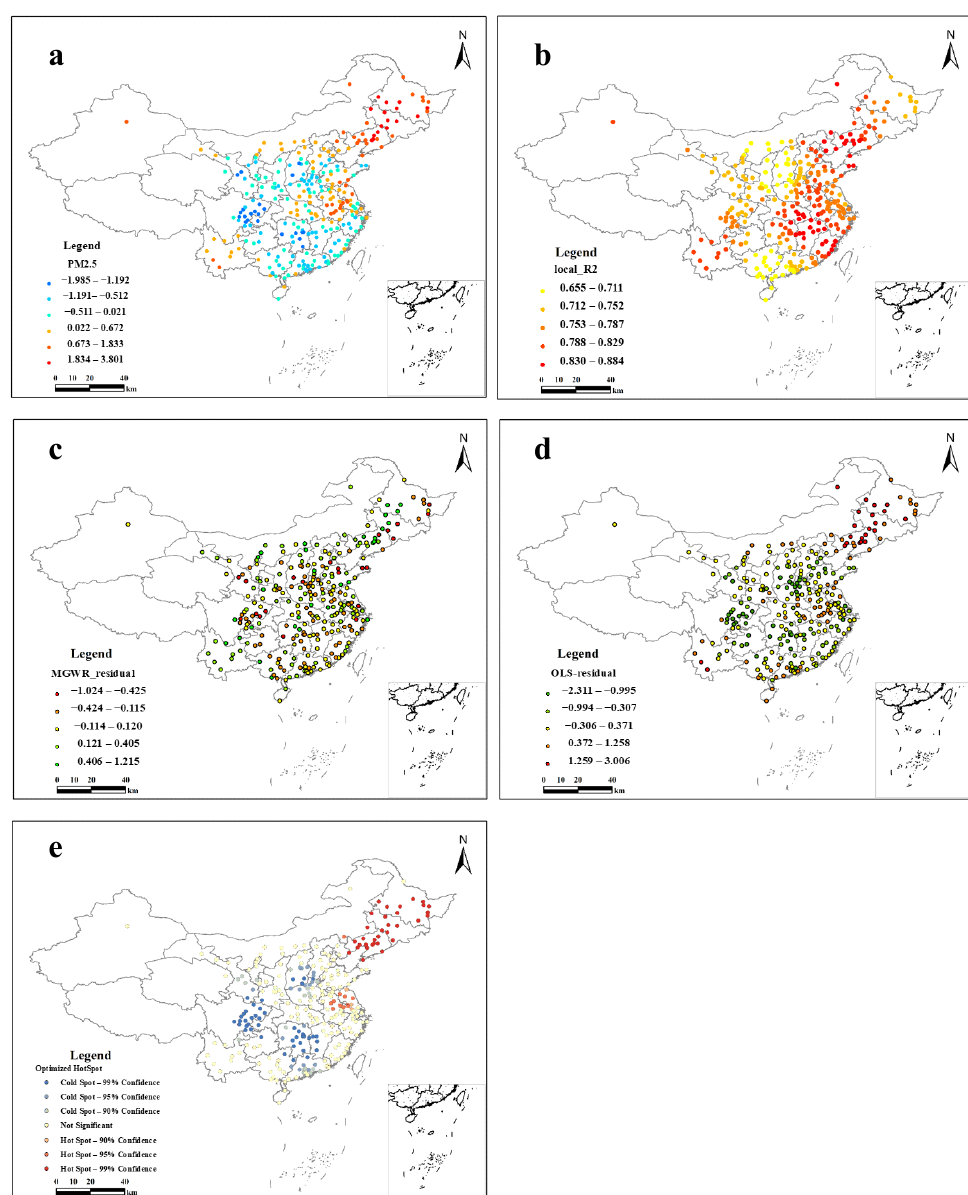
Figure 2. The spatial distribution of changes in PM 2.5 concentrations in major Chinese cities from 2005 to 2015. Spatial distribution characteristics of PM 2.5 ( a ); Spatial distribution of R 2 ( b ); Residual of MGWR ( c ); Residual of GWR ( d ); Analysis of cold and hot spots of PM 2.5 ( e ).